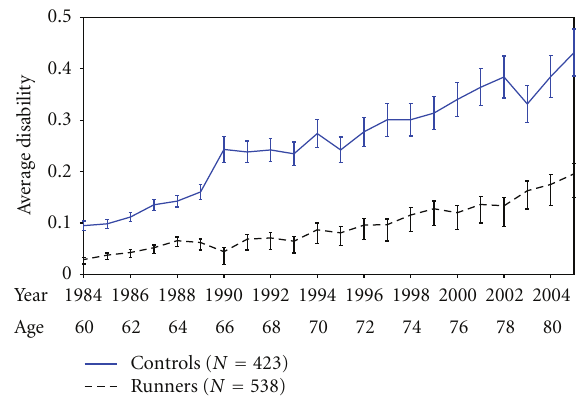
Figure 1: Average disability scores by age and calendar year, Run- ner’s and community controls